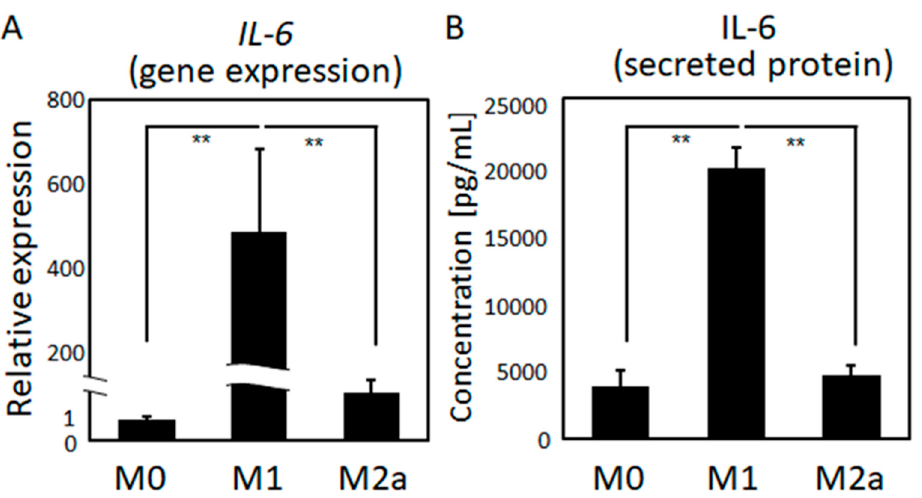
Figure 5. Quantitative comparison of the ( A ) gene expression and ( B ) secreted protein levels of IL-6 among the three types of polarized macrophages is shown; ** p < 0.01.